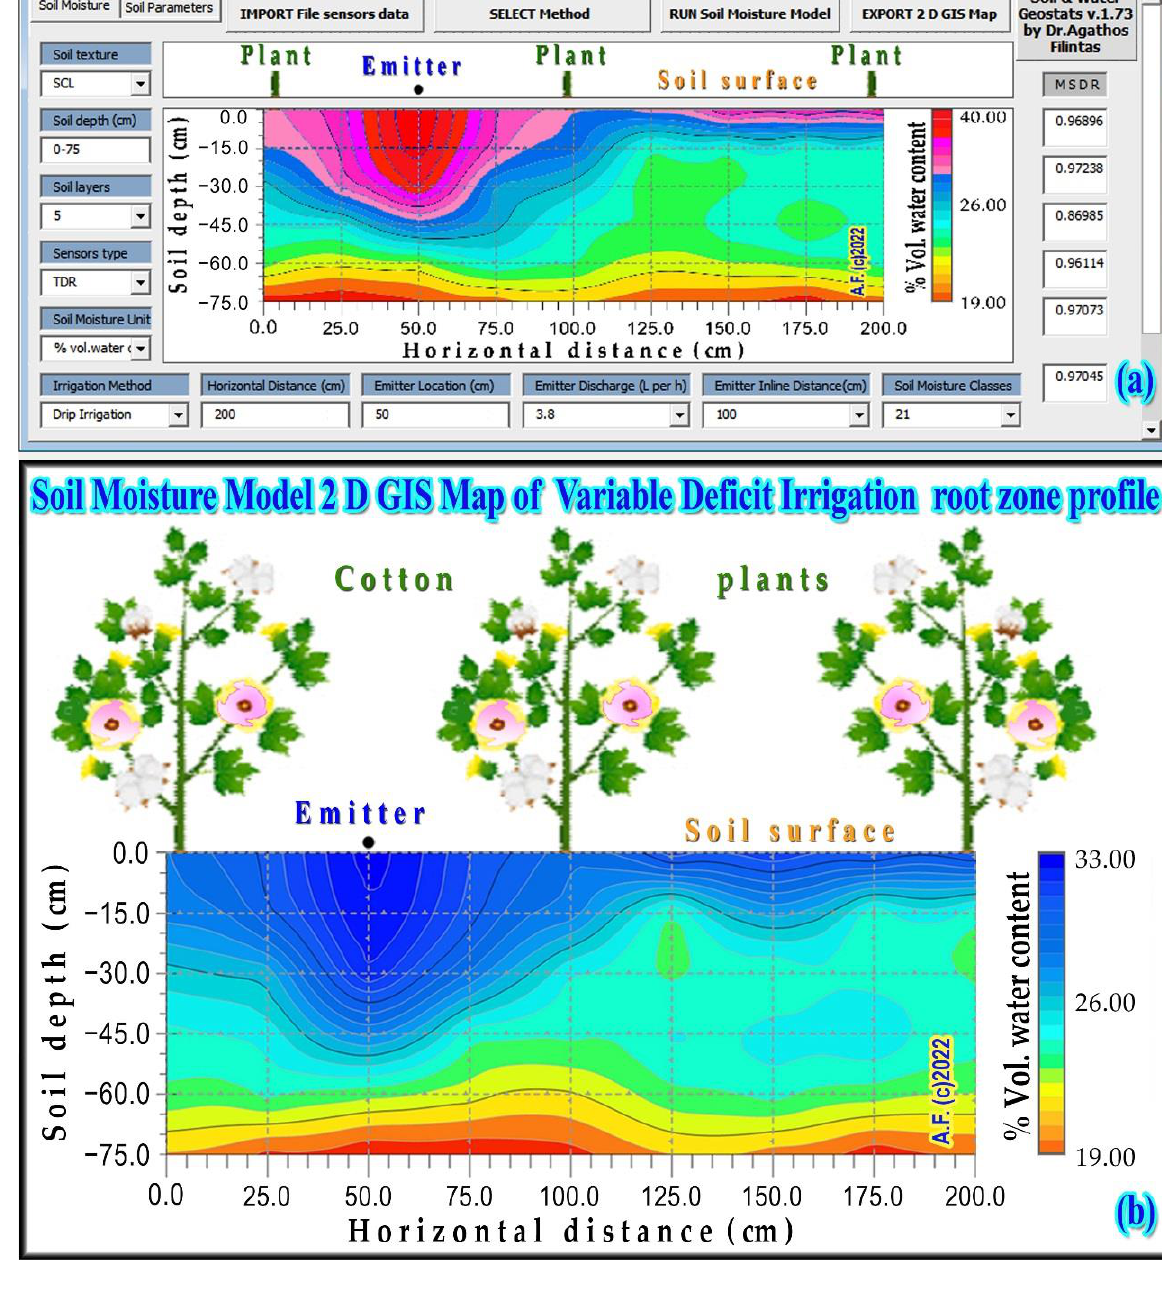
Figure 3. An example of soil moisture model 2D GIS map of cotton’s root-zone soil profile modeled from TDR sensors’ data measurements in DAS 94 (the Lmid growth stage) using “Soil & Water Geostats v.1.73” software for: ( a ) a farmers’ irrigation treatment plot after irrigation and a rainfall event in the next day, ( b ) a VDI irrigation treatment plot.